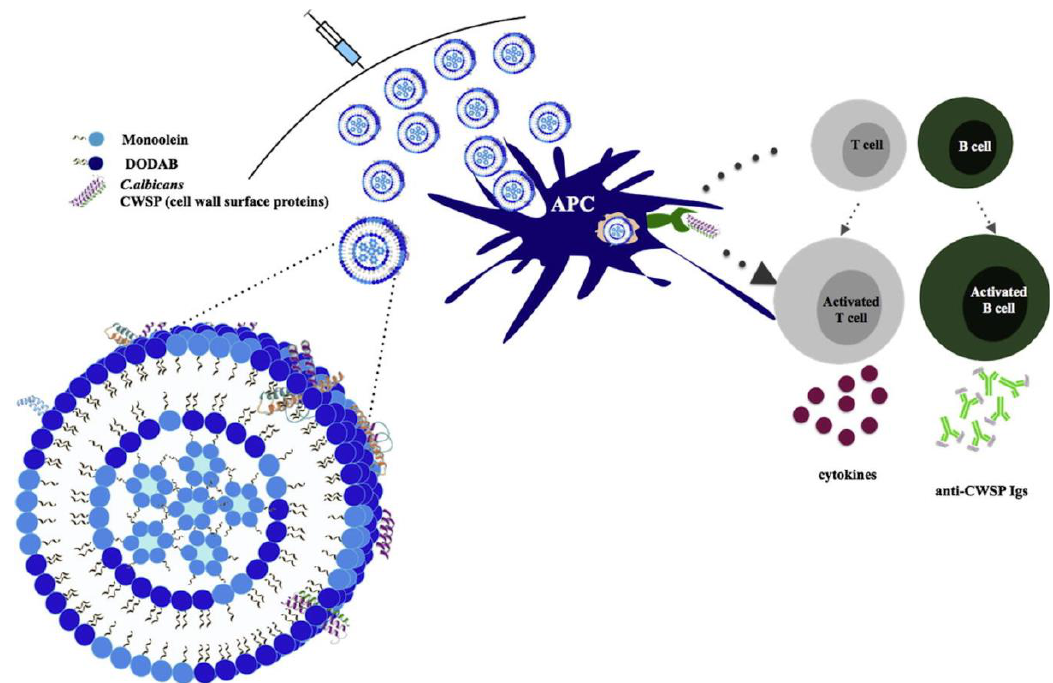
Figure 4. Activation of cell-mediated immunity and humoral response by DODAB/monoolein liposomes incorporating cell wall surface proteins of Candida albicans (CWSP). Reprinted from [77] with permission from Elsevier, Copyright 2015.